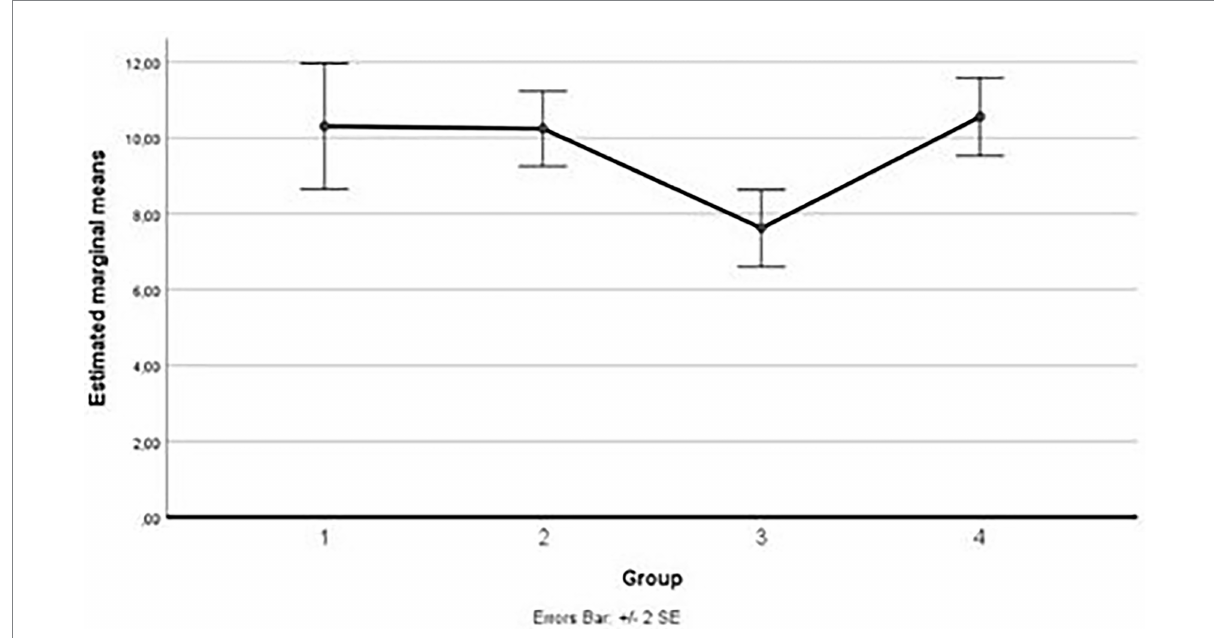
FIGURE 8 Estimated marginal means for the fear of pain (after the vision of